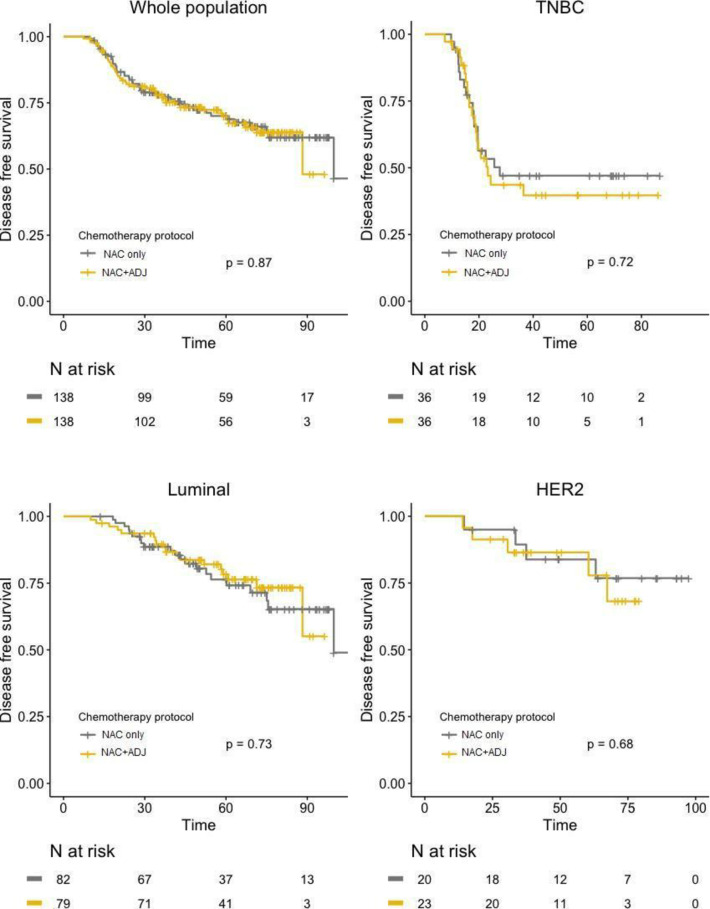
DFS curves in NAC only and NAC+ADJ groups for whole population and by pathological subtype (TNBC, luminal, and HER2-positive tumors), after PS matching.